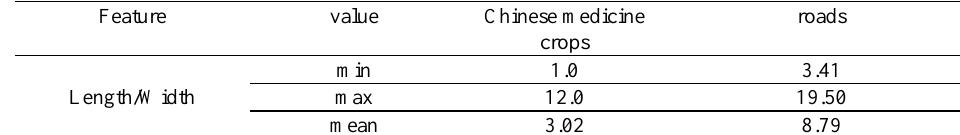
Table5. Spectral characteristic values of different types of ground objects.